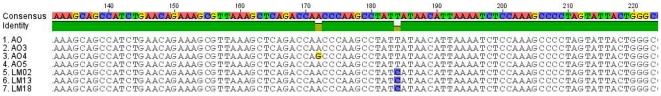
An example of alignment with a group specific SNP (16S ribosomal RNA gene).